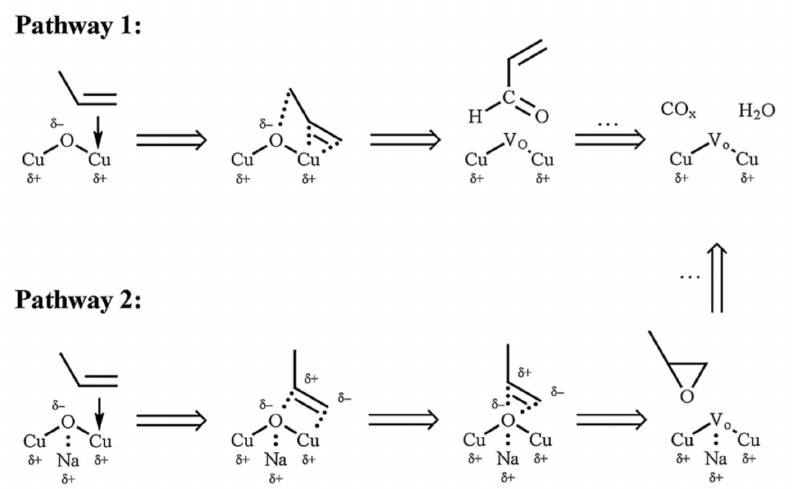
Figure 15. Effect of alkali metals on selectivity of propylene oxidation over CuO x /SiO 2‘ [16]. Copy- right 2018,